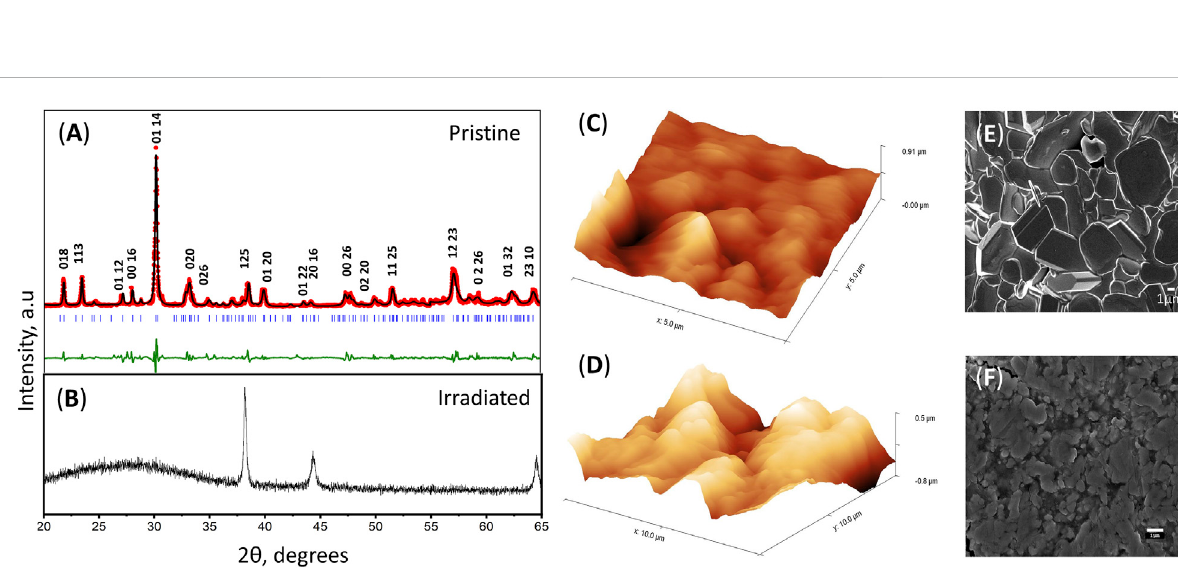
FIGURE 2 (A) The x-ray diffractogram of polycrystalline K 2 Bi 4 Ti 4 WO 18 . The bottom pattern (B) shows the amorphization post irradiation. The AFM images also depict an expected increase in the surface roughness after irradiation (D) , when compared before irradiation (C) (E) The electron micrograph shows a grain distribution typical of bismuth layered structure. (F) The irradiation leads to surface amorphization with no clear